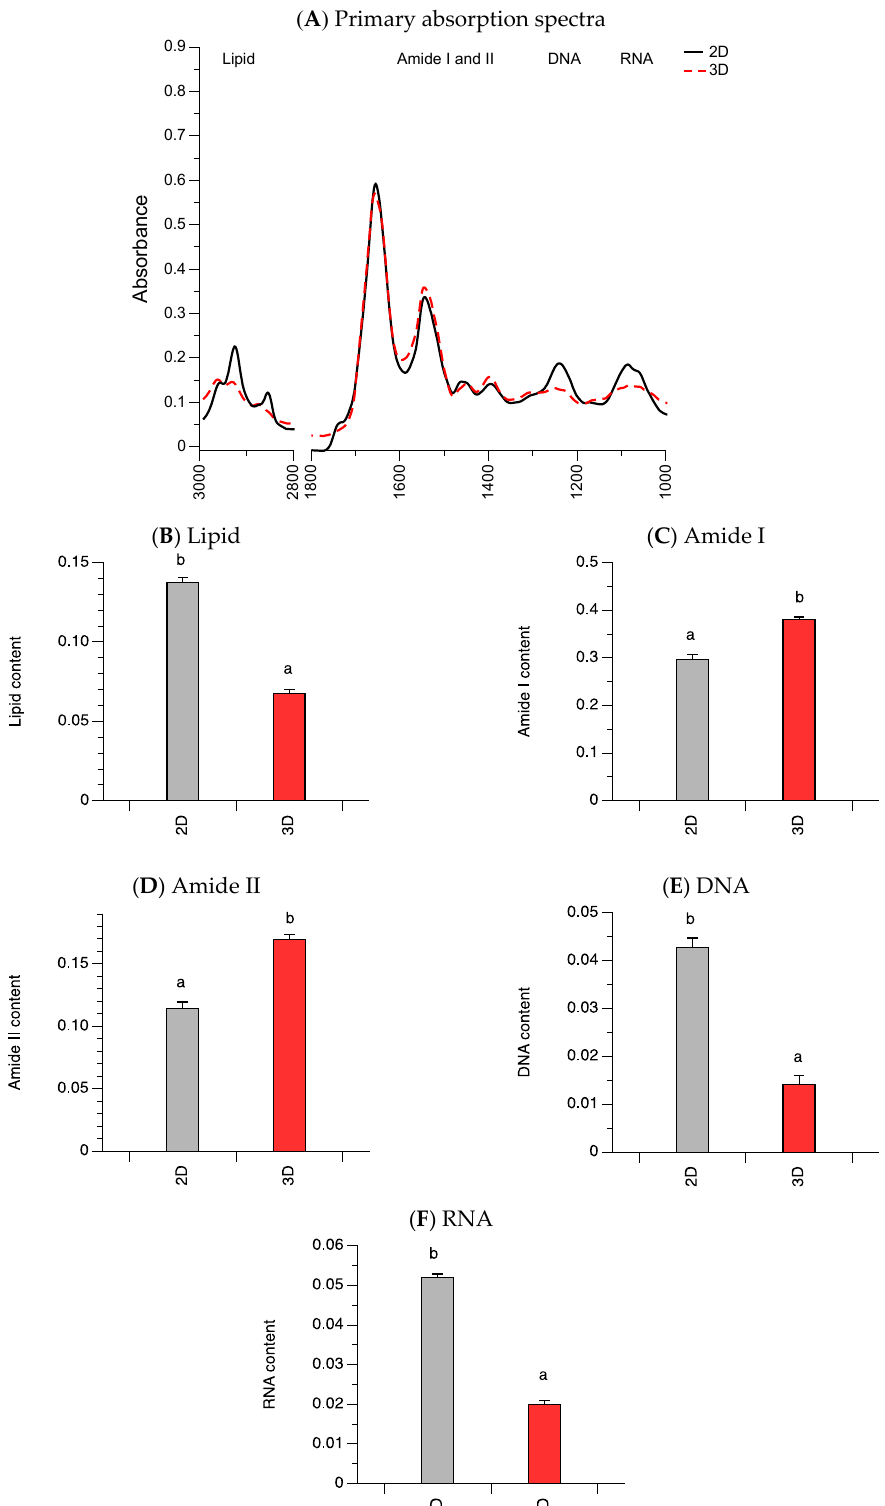
Figure 1. The primary absorption spectra and integration ratios of the five spectral regions ( 2813–2992 cm − 1 , 1600–1700 cm − 1 , 1500–1600 cm − 1 , 1180–1280 cm − 1 , and 1040–1140 cm − 1 ). ( A ) Average absorption spectra of the cell culture systems: two-dimensional (2D) (5000 cells/per replicate) ( black; 76 spectra ) and three-dimensional (3D) spheroids (5000 cells/per spheroid) ( red; 73 spectra ). ( B – F ) Integration ratios for each spectral region, including the lipid, amide I, amide II, DNA, and RNA ( n = 3) . Each different letter represents a statistical difference between groups ( p < 0 . 05 ).